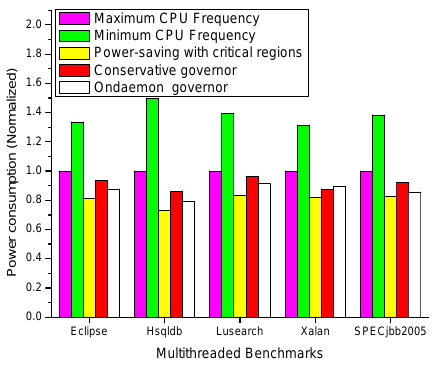
Figure 8. The Power consumption of power- saving techniques